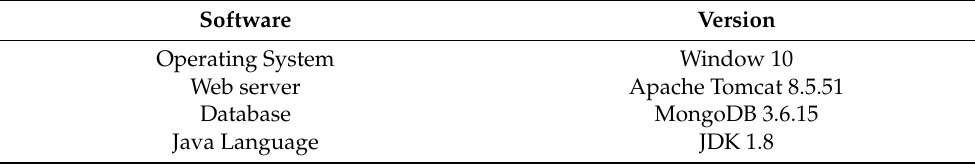
Table 5. Off-chain EPCIS software environment.